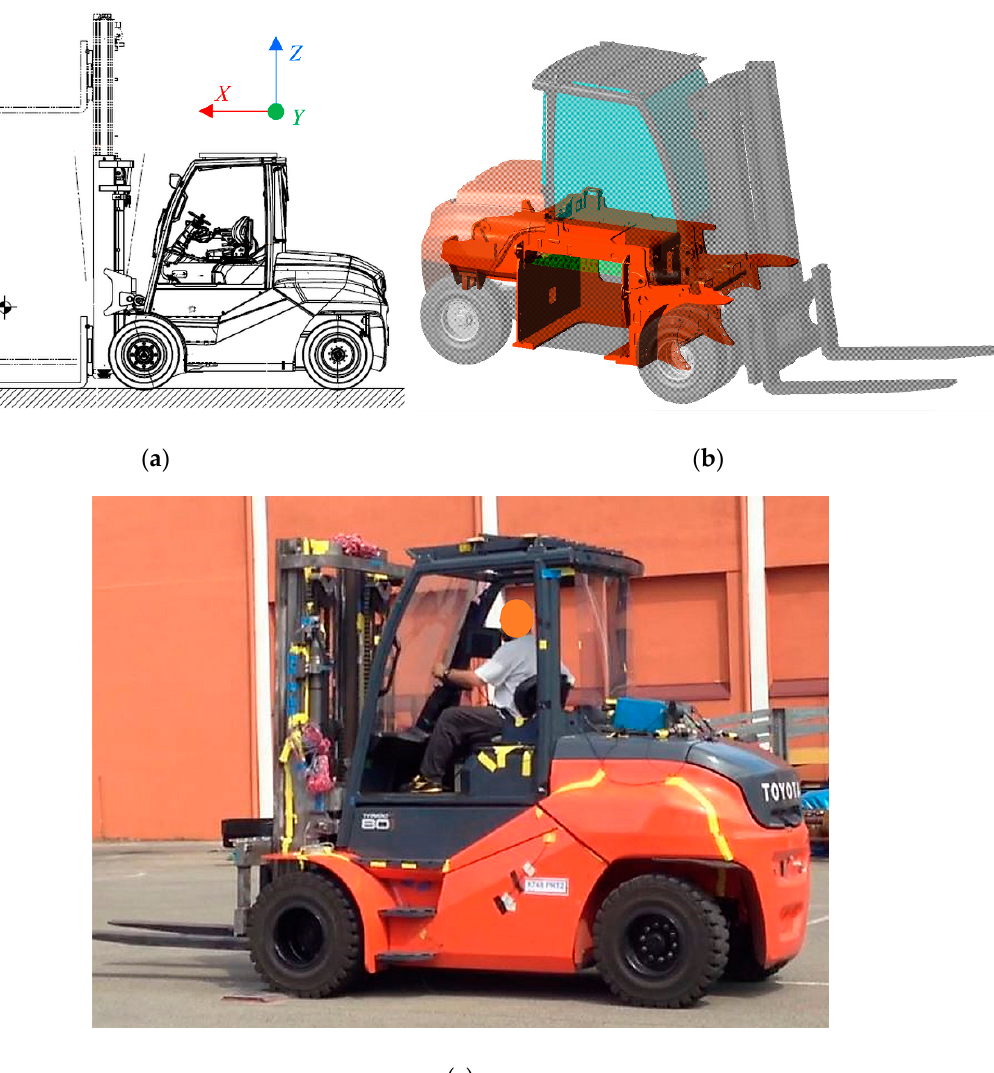
Figure 1. Traigo 80 forklift: ( a ) Full-assembly draft; ( b ) CAD model of the chassis; ( c ) Picture of the tested vehicle.